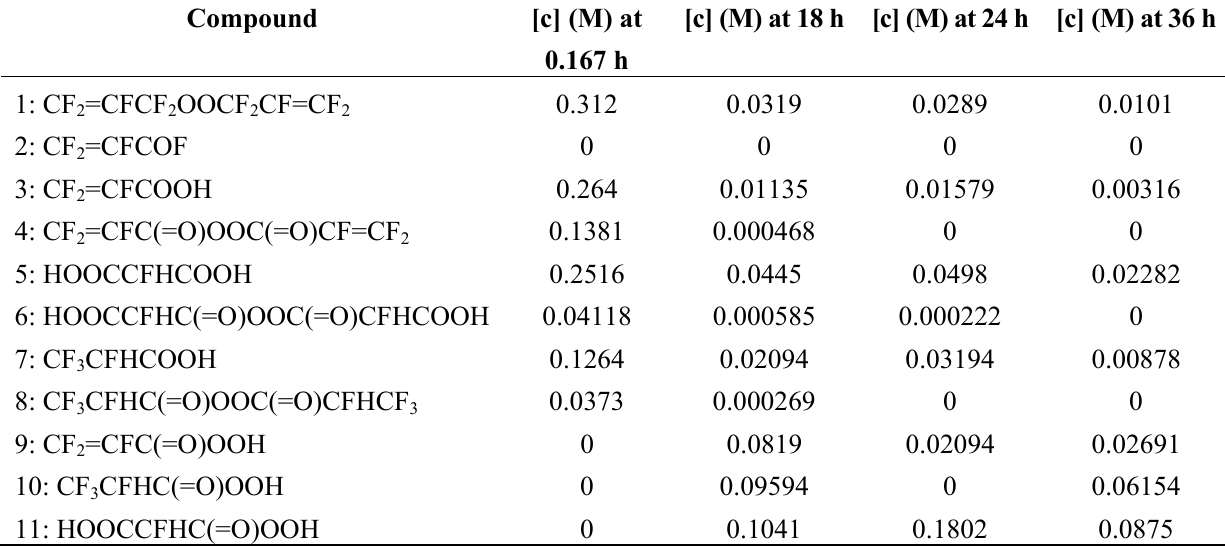
Table 13. Sum of aqueous H decomposition as a function of time at 20 °C.